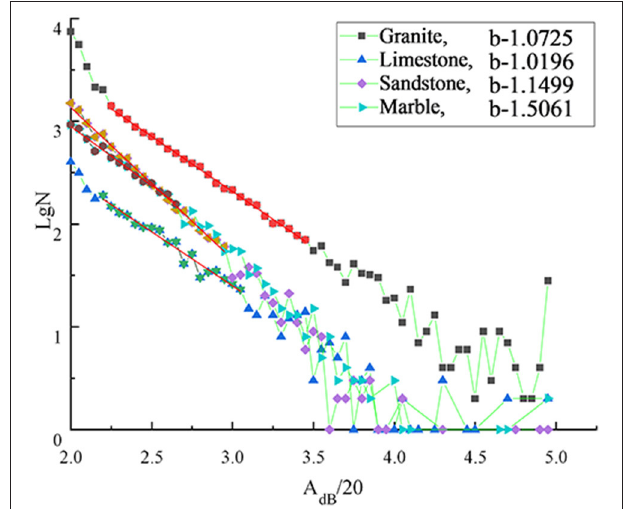
FIGURE 3 | b -Values of four kinds of rocks obtained by the FGS